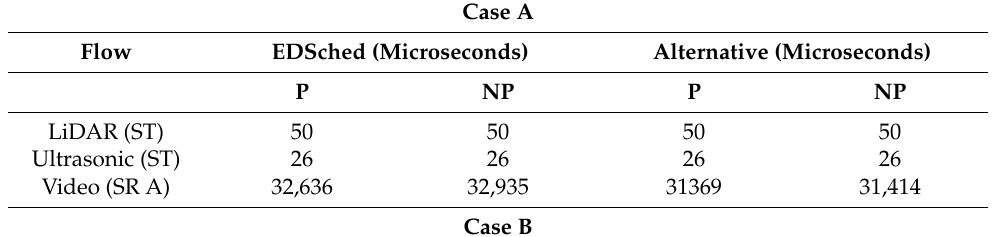
Table 3. Max end-to-end delays with (P) and without (NP) preemption for the other traffic classes. Case A